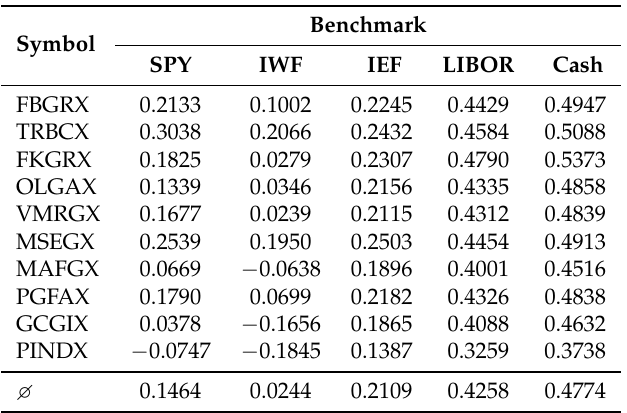
Table 3. ICVs of the mutual funds with respect to the benchmarks. The standard errors can be approximated by 1/ √ m = 0.2502 (see Equation (2)).